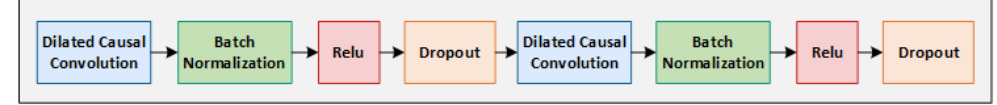
Figure 3. TCN block architecture.